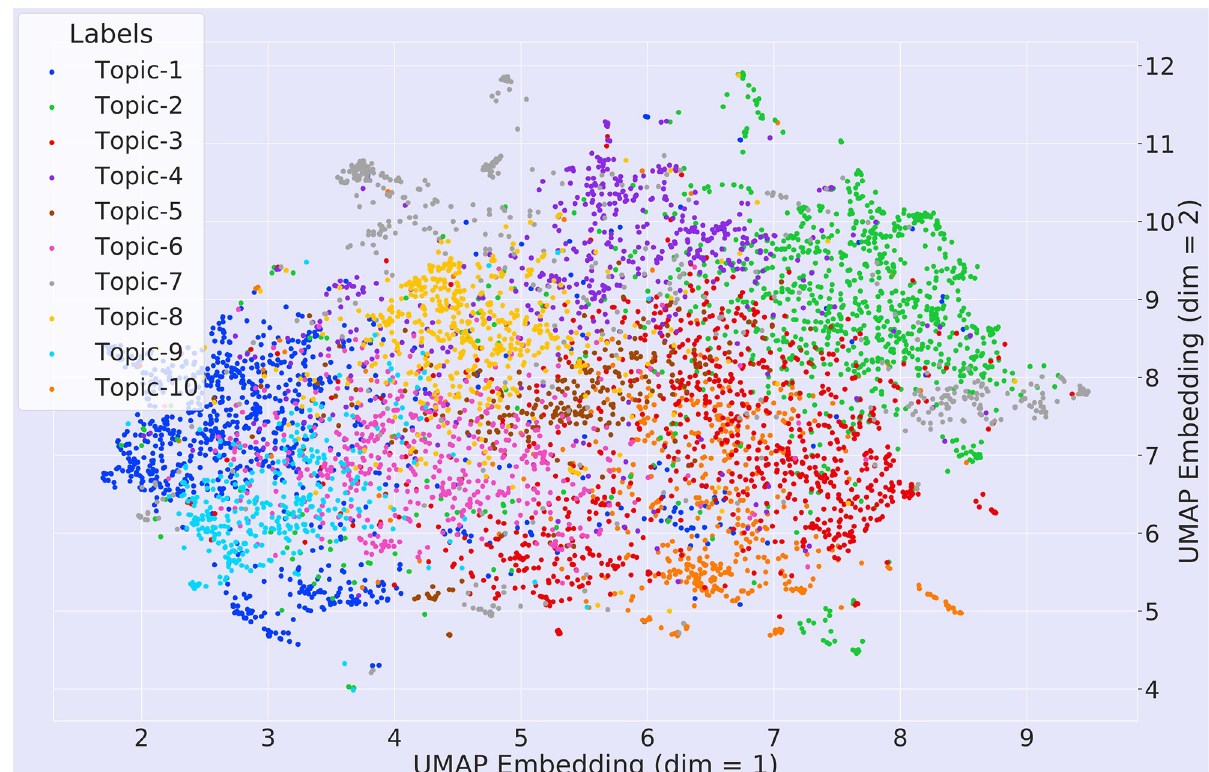
Fig 9. Visualisation of different topics of 108